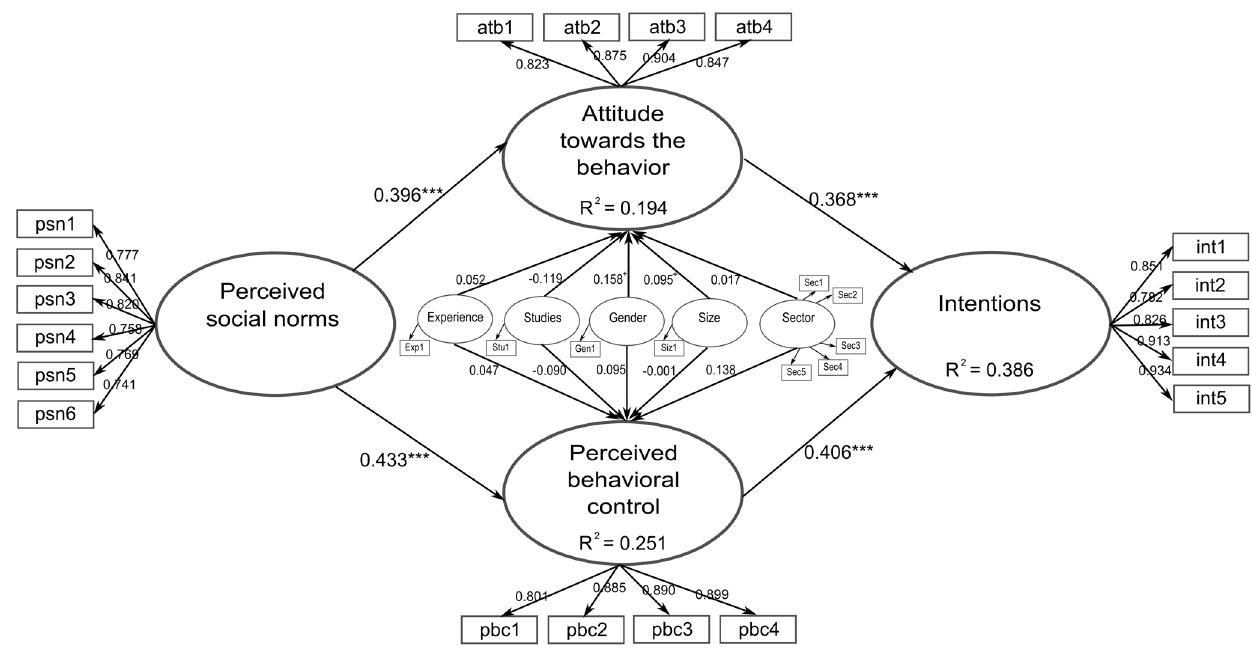
Figure 5. Indicator Charges of different constructs.